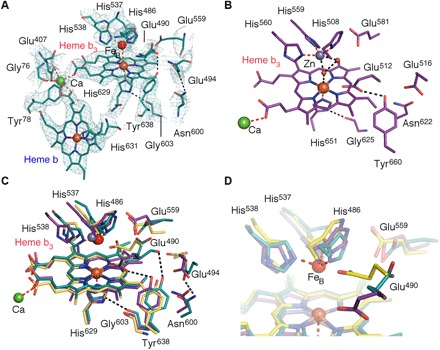
Active-site configurations in NORs.(A) Binuclear center and corresponding density of AxqNOR with FeB (red sphere) coordinated by His486, His537, and His538, where Glu490 facing away from FeB with calcium (green sphere) is ligated by heme b and heme b3 propionates, Glu407, Try78, and Gly76 (the latter three residues are highly conserved in qNORs). Tyr638 and Gly603 provide additional structural support to the Glu490 backbone carbonyl oxygen and His629 ND1 atom, respectively. (B) Binuclear center of GsqNOR with zinc and water molecules shown as gray and red spheres, respectively. (C) Comparison of side-chain conformations (numbered according to AxqNOR) viewed from above the binuclear center in AxqNOR (teal), GsqNOR (purple), and PacNOR (yellow). Zinc is shown as a gray sphere, while FeB is colored red. (D) Zoomed-in view of the binuclear center, highlighting the Glu490 orientation of GsqNOR, AxqNOR, and PacNOR, colored as in (C).